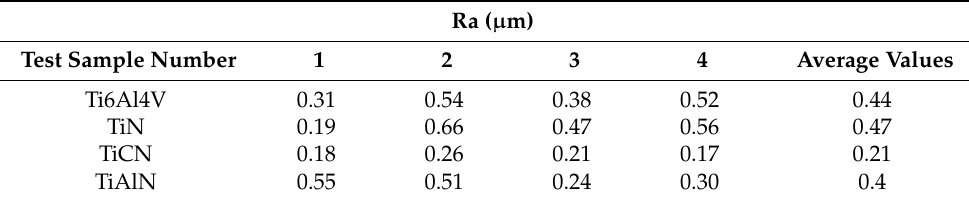
Table 2. Average surface roughness Ra ( µ m) values for Ti6Al4V alloy and coatings.